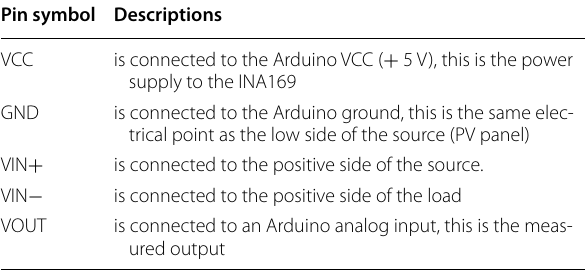
Table 5 Connectors of the INA169 current sensor module